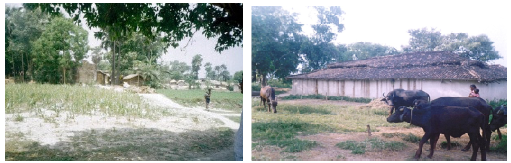
Fig. 3 Housing pattern near Gurhi village showing peri- domestic vegetation and mixed dwellings.